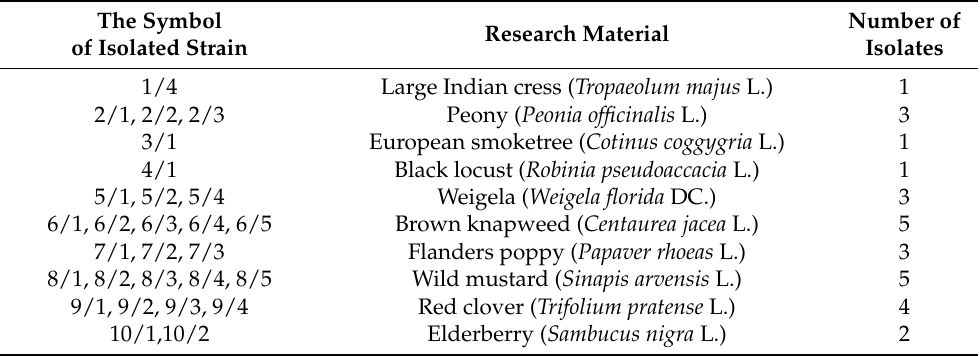
Table 2. LAB strains were isolated from flowers from which honeybees most often collect